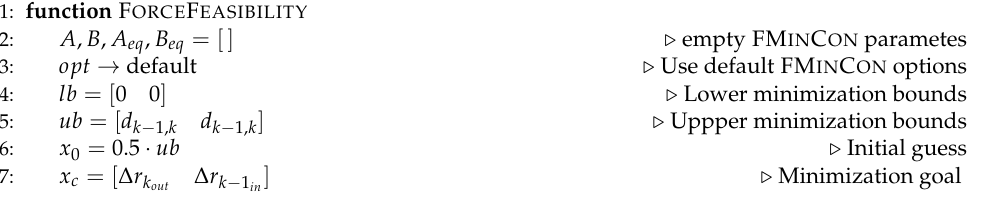
Algorithm 2 Force feasibility